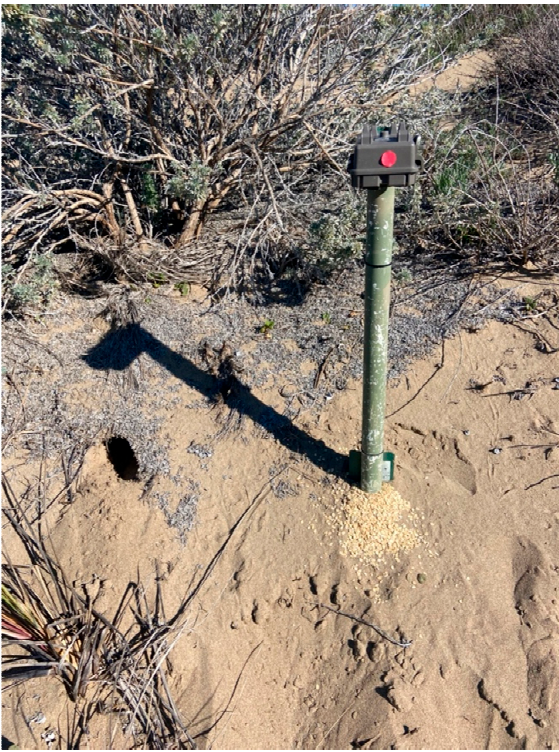
Figure 3. Set up of baited camera station used for surveys at the Morro Bay sandspit, CA. Cameras were deployed for a minimum of three nights. Most cameras were deployed longer (dependent on personnel availability and weather conditions). GPS coordinates, date, transect number, polygon number, and camera number were recorded for each camera. Cameras were deployed within 3 to 12 days following the transect